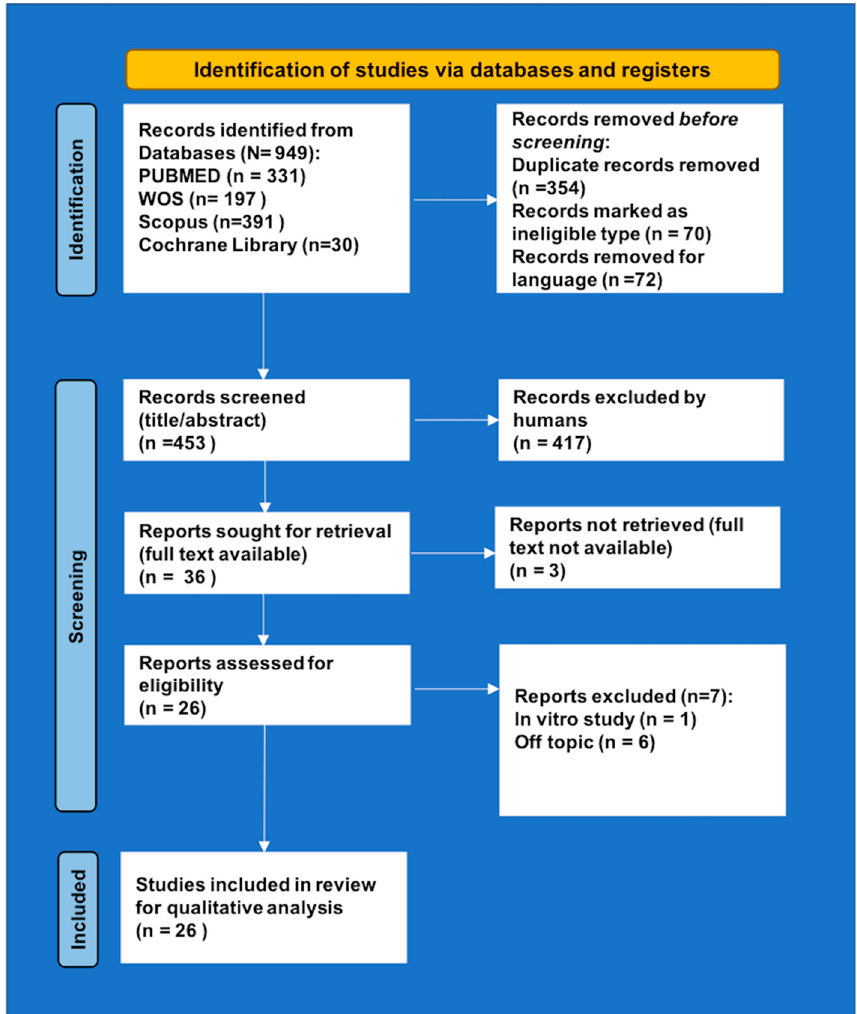
Figure 2. PRISMA 2020 flow diagram.